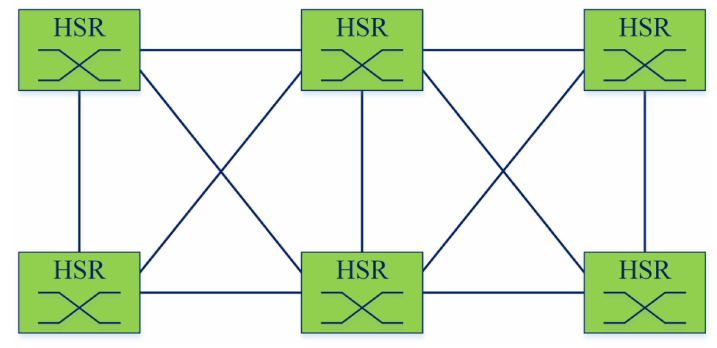
Figure 8. SwitchBox-based HSR in mesh